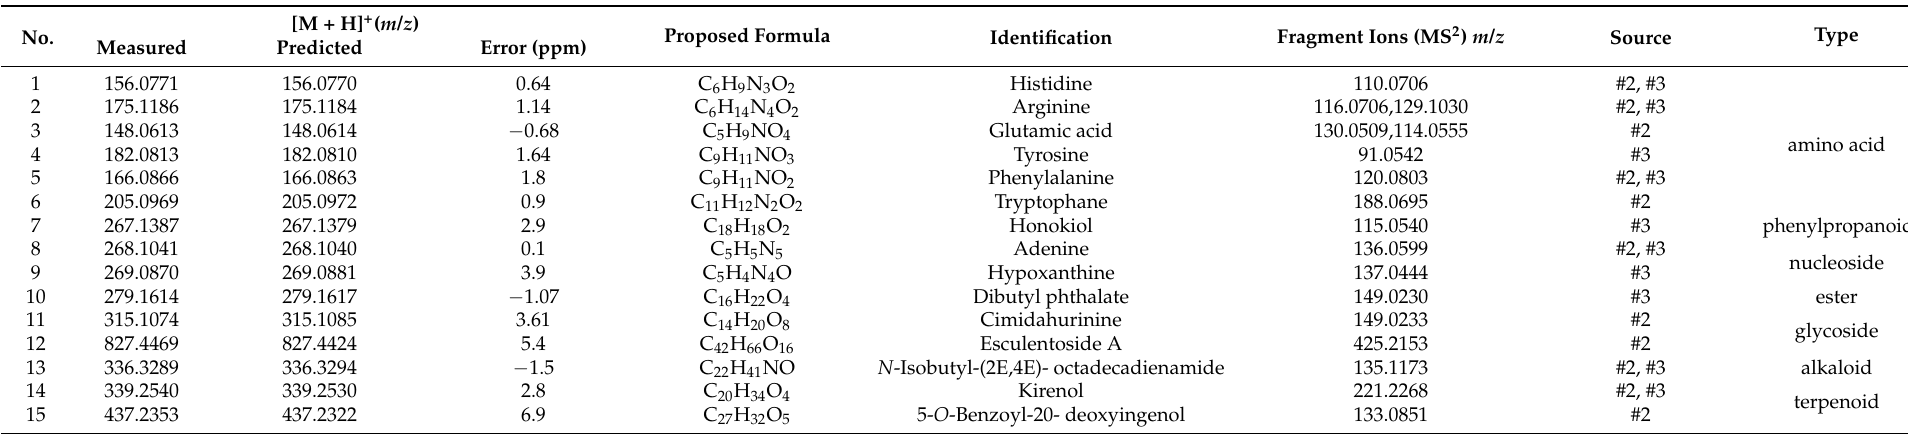
Table 1. The different components of #2 and #3 fractions from F. luteovirens analyzed by UFLC-Q-TOF-MS/MS in positive